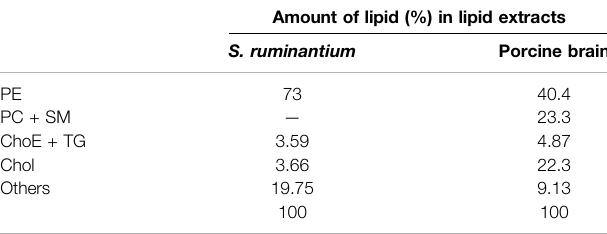
TABLE 3 | The composition (%) of lipids in the lipid extracts from S. ruminantium and porcine brain.